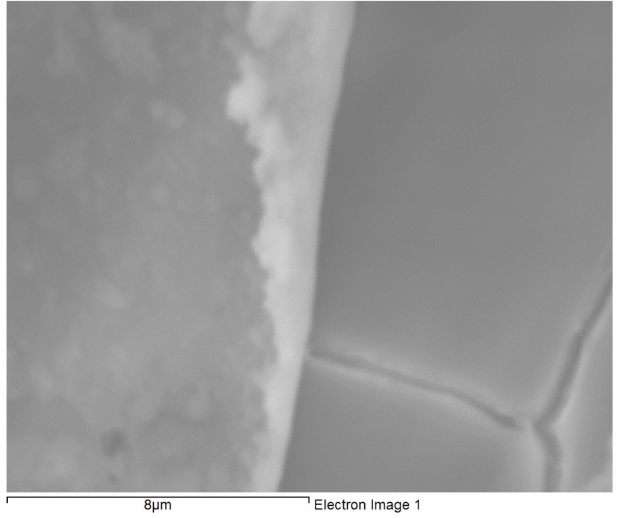
Figure 2. Delamination in BTSE coating on AZ91D exposed to 0.1 M NaCl for 100 h, that enabled determination of coating